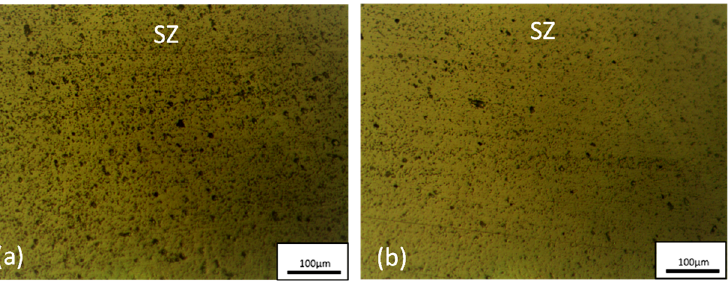
Figure 27. Microscopy image of SZ at 1150 rpm and 25 mm/min for, ( a ) TTH and ( b ) CTH.